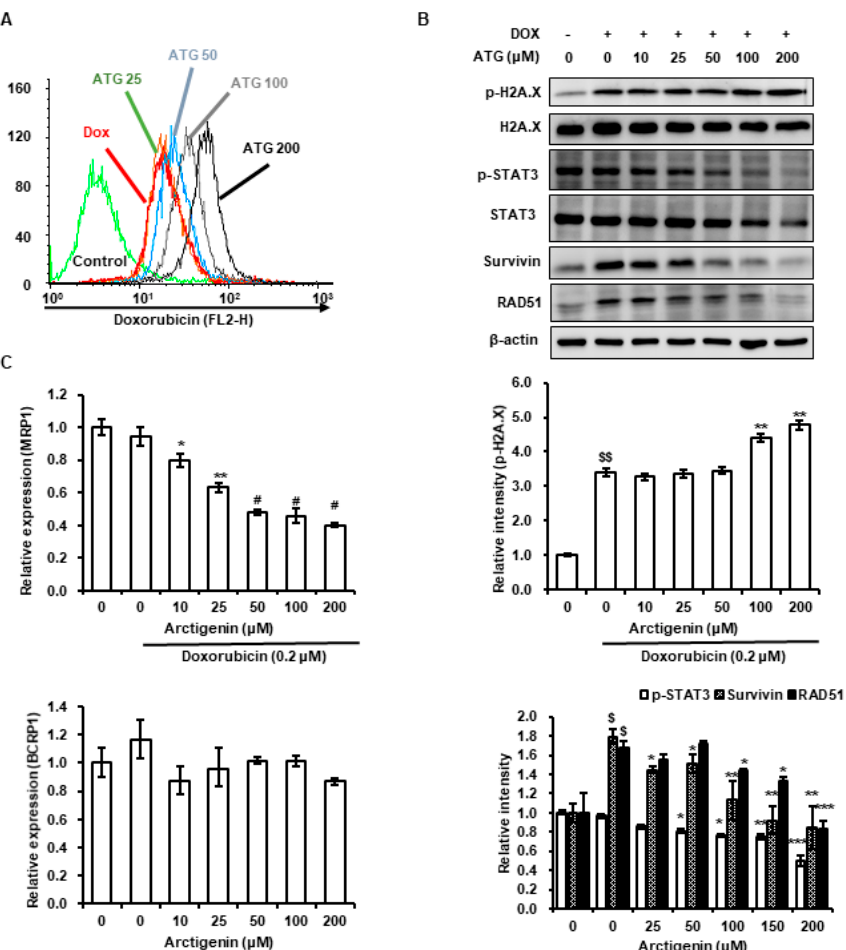
Figure 2. Effects of ATG on DOX uptake, the transcriptions of multidrug resistance-associated protein 1 (MRP1) and breast cancer resistance protein 1 (BCRP1), the phosphorylations of H2A histone family member X (H2A.X) and signal transducer and activator of transcription 3 (STAT3), and the expressions of survivin and DNA repair protein RAD51 homolog 1 isoform 1 (RAD51) in MDA-MB-231 cells. ( A ) Cells were grown for 48 h with various concentrations of ATG (0–200 μ M) prior to being treated with 0.2 μ M DOX treatment for 24 h. DOX uptake was analyzed by flow cytometry. ATG accelerated DOX uptake in a concentration-dependent manner. The X-axis shows fluorescence intensities of intracellular DOX and the Y-axis cell numbers per channel. ( B ) Cells were attached for 24 h and further grown for 24 h in DMEM medium supplemented 2% fetal bovine serum (FBS), 0.2 μ M DOX, and various concentration of ATG (0–200 μ M). MRP1 gene expression was suppressed by ATG/DOX co-treatment. Relative expressions of MRP1 and BCRP1 genes were evaluated in triplicate and normalized versus glyceraldehyde-3-phosphate dehydrogenase (GAPDH). *, ** and # indicate p < 0.05, p < 0.01, and p < 0.001 vs. DOX treated cells. –: 0.2 μ M DOX-untreated, +: 0.2 μ M DOX-treated ( C ) Cells were attached for 24 h and then co-treatment with 0.2 μ M DOX and various concentration of ATG (0–200 μ M) for 72 h in DMEM medium supplemented with 2% FBS. The proteins in whole cell lysates were separated by 8% or 15% sodium dodecyl sulfate (SDS)-polyacrylamide gel electrophoresis (PAGE) and transferred to polyvinylidenefluoride (PVDF) membranes. Bands were densitometrically analyzed using Scion Image and band densities were normalized versus β -actin. $ and $$ indicate p < 0.01 and p < 0.005 vs. non-treated control. *, ** and *** indicate p < 0.05, p < 0.01 and p < 0.005 vs. DOX treated cells. (B, C) All experiments were conducted independently three times and results are presented as means ±